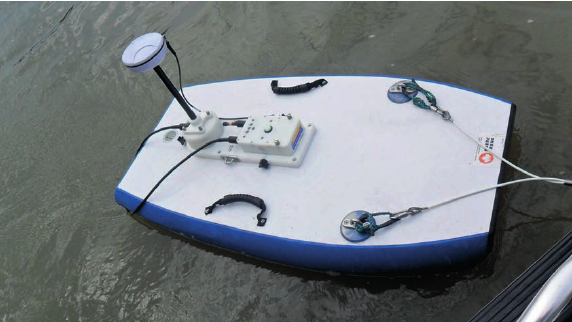
Fig. 3 M9 ADCP River Surveyor from the University of Manitoba (Kimiaghalam et al ., 2013).